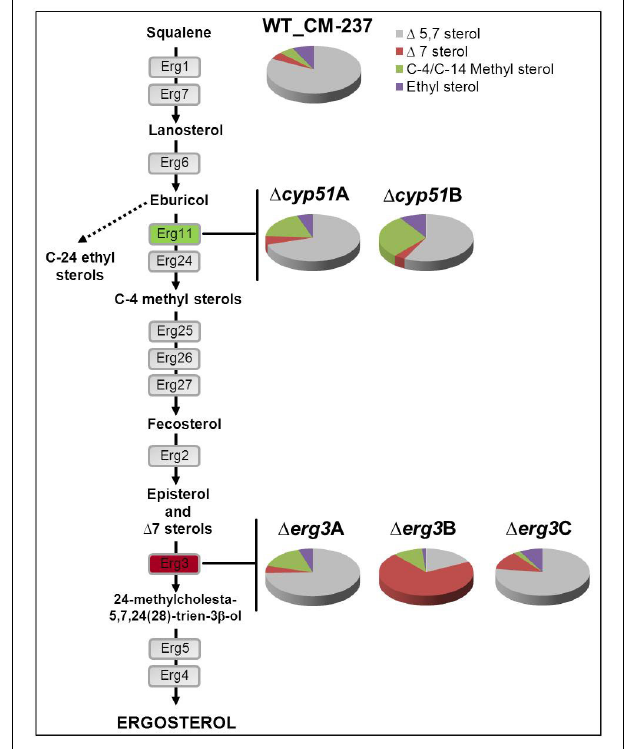
FIGURE 1 | Ergosterol biosynthetic pathway. Sterols of A. fumigatus wild-type strain (CM-237), and Δ cyp 51A, Δ cyp 51B (marked in green), Δ erg 3A, Δ erg 3B, and Δ erg 3C (marked in red) derived mutant strains. Sterols are clustered and represented in cake plots as the percentage of total sterols: Δ 5 sterols (1, 2, 3, 4, 6, 8 in gray), C-4/C-14 methyl sterols (11, 12, 13, 14 in green), Δ 7 sterols (5, 7, 9 in red), and ethyl sterols (10 in purple) according to the sterol identification in A. fumigatus ( Table 1